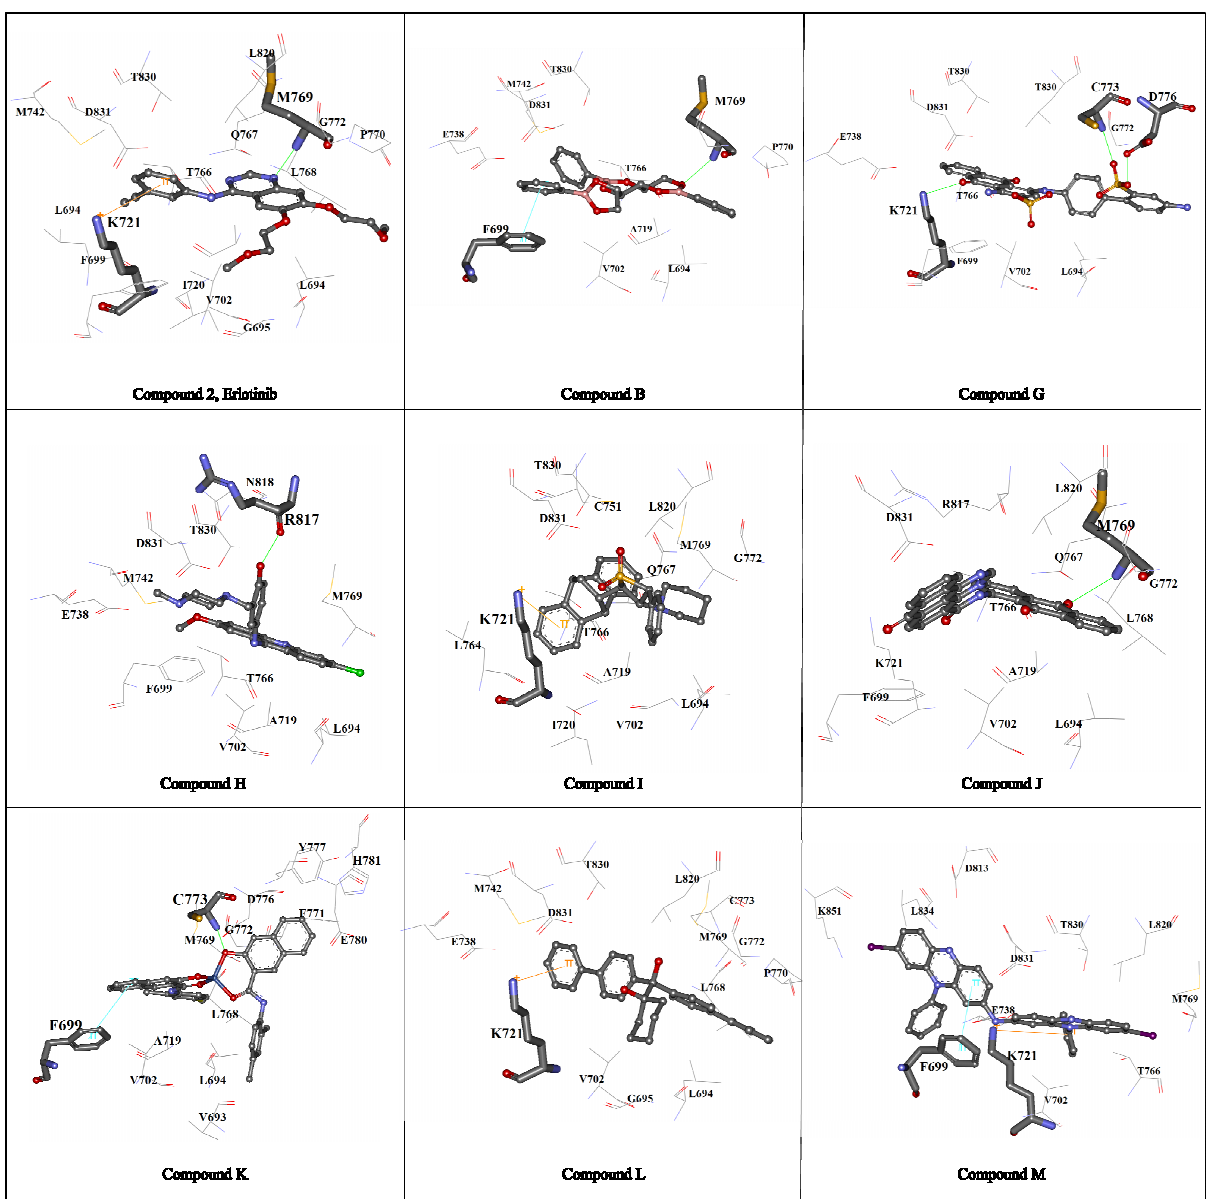
Figure 5. The 3D diagrams showing the interaction between the EGFR-TK and the eight hit compounds using Discovery Studio 2.5 (Accelrys Inc., CA, USA). The hit compounds, the amino acid residue interacting with the compounds and the other residues around the binding pocket are presented in ball and stick , stick and line , respectively. Hydrogen bond, π−π , and cation- π interactions between the compounds and the binding residues are shown as green solid, light blue and orange lines,